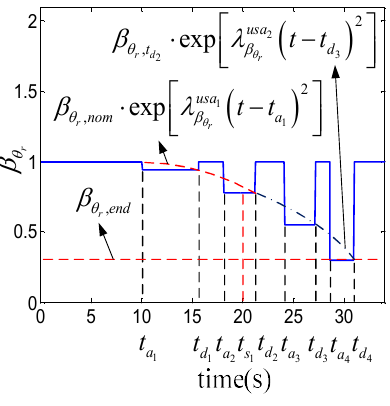
Figure 7. Fault profile in β θ r